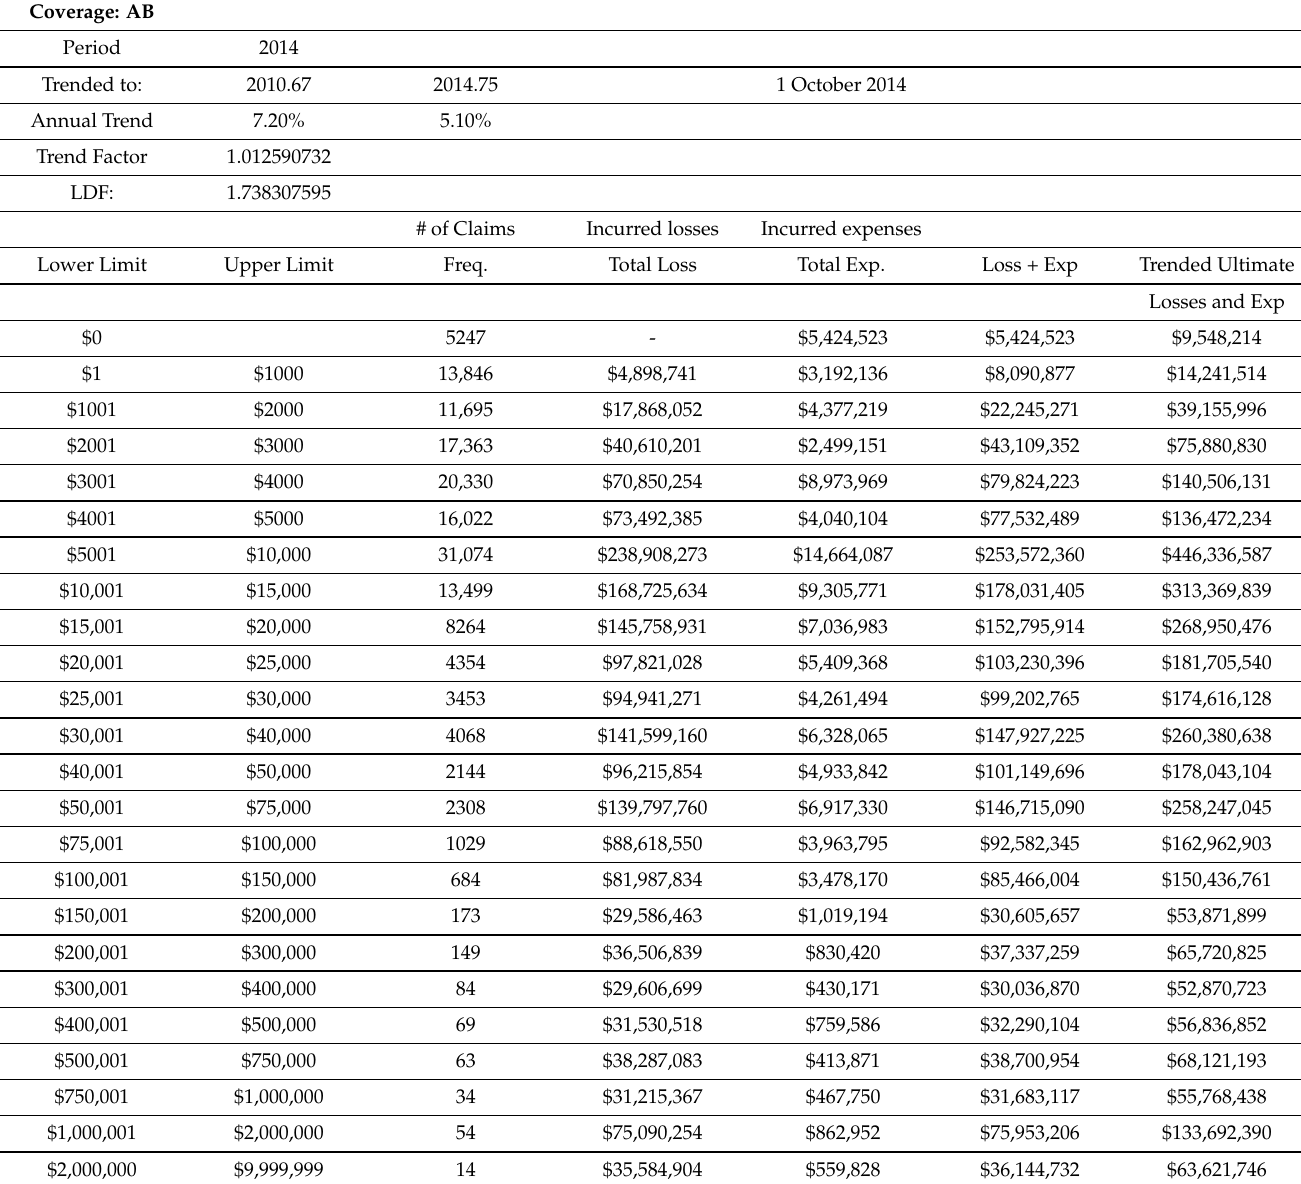
Table 1. The size of loss distribution in terms of claim frequency, claim amount, expense and aggregate loss for the combination of urban region, AB coverage and 2014 accident year for the 2014 report